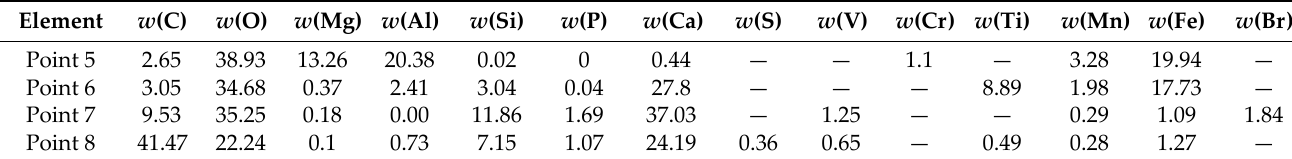
Table 4. Sr‑8 SEM point element distribution (mass fraction, %).